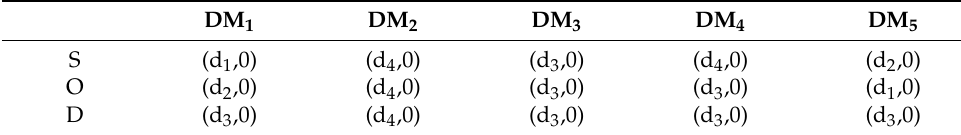
Table 6. Interval 2-tuple linguistic variables for the importance of risk